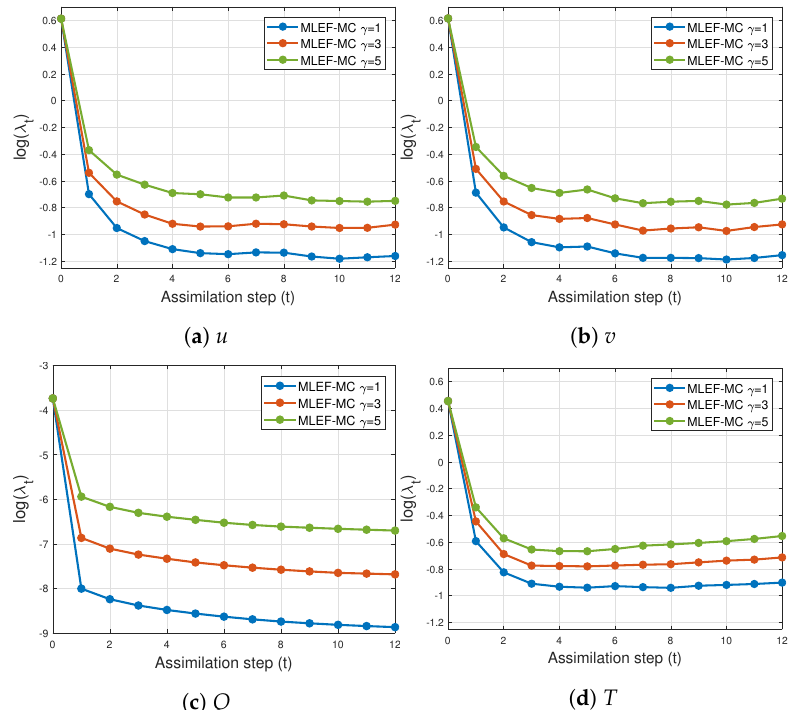
Figure 12. Time evolution of analysis errors for different values of parameters γ and r (MLEF-MC). s = 1 (full observational network).